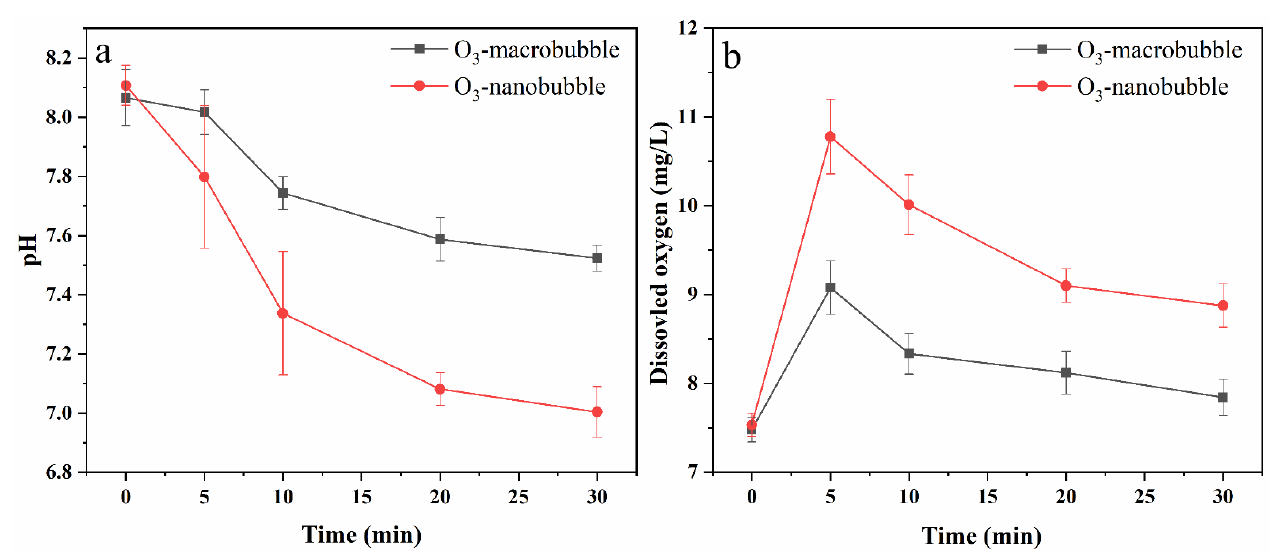
Figure 3. The dynamics of pH ( a ) and dissolved oxygen ( b ) in both treatment groups.